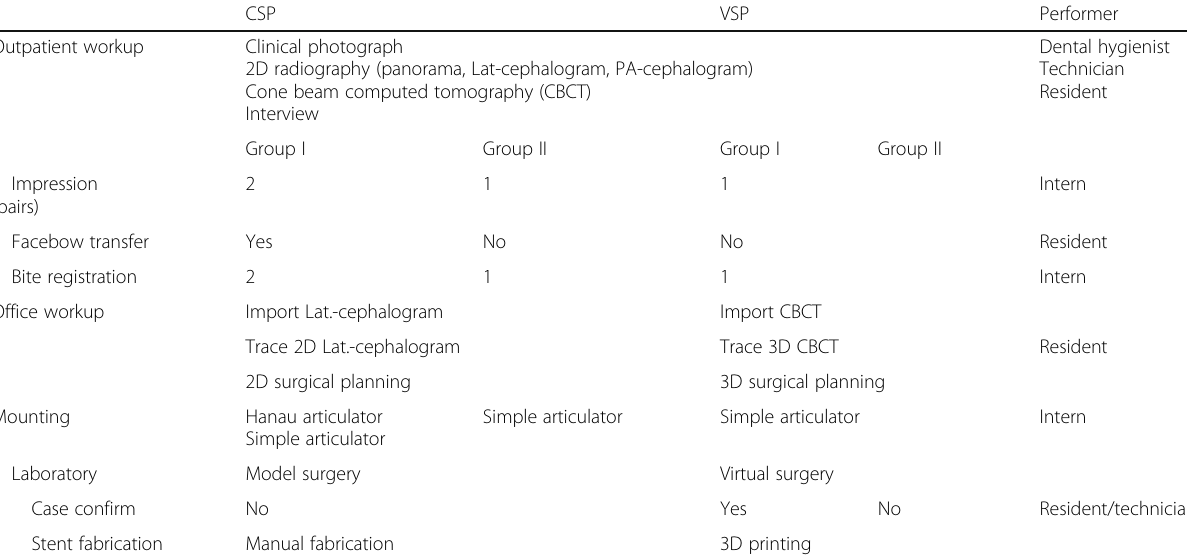
Table 1 Progress workflow and performer for CSP and VSP CSP